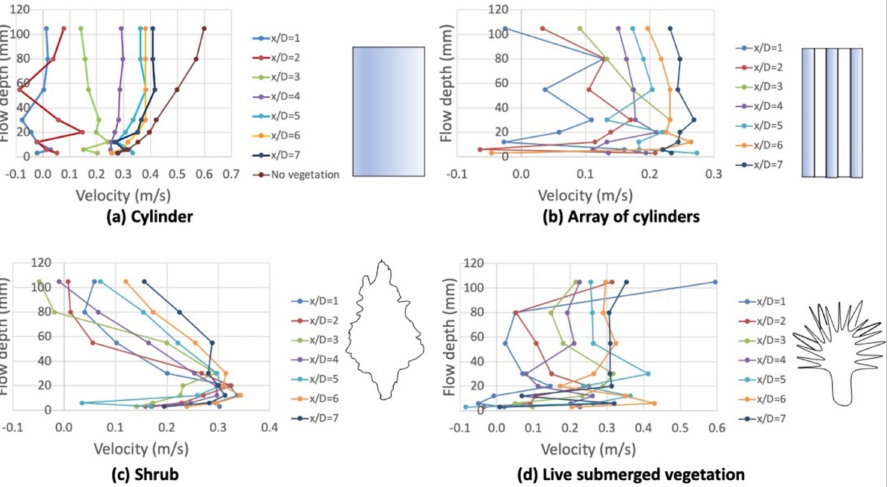
Figure 10. Stream-wise velocity profiles for the characteristic types of vegetation elements used in the